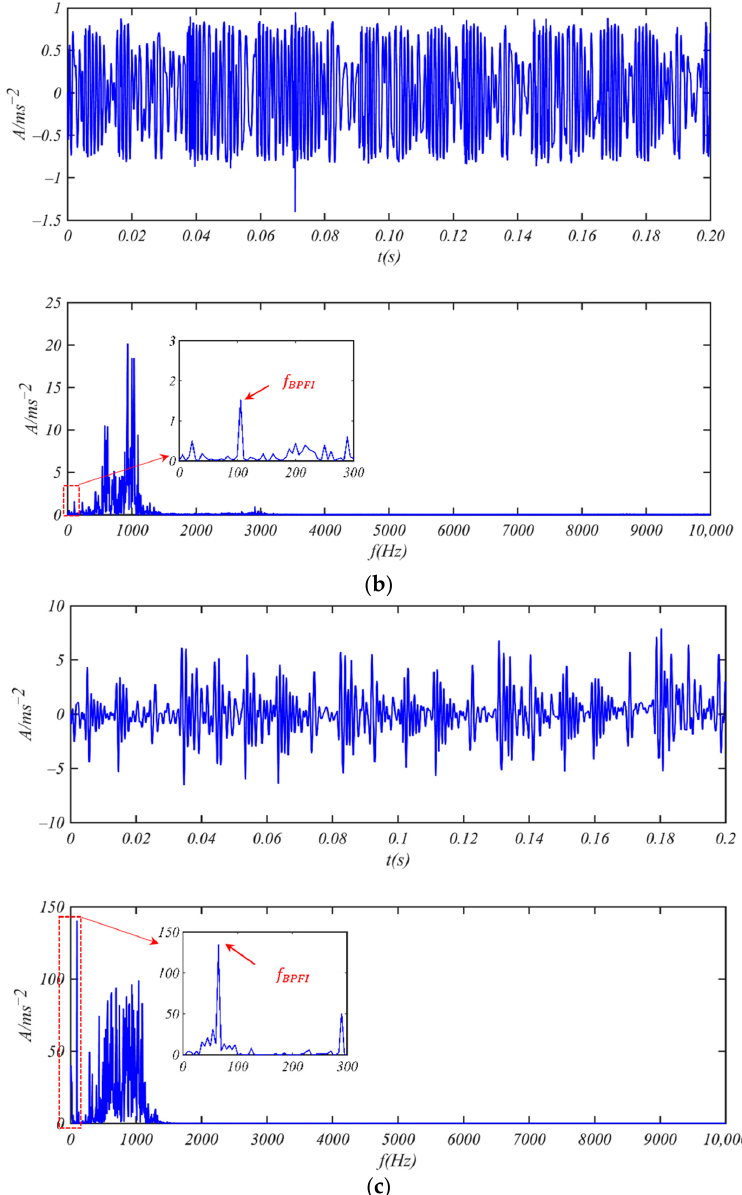
Figure 11. Comparison between different models to process bearing 6200 with inner ring fault: ( a ) origin time-domain waveform and spectrum; ( b ) time-domain waveform and spectrum processed by CBSR model; and ( c ) time-domain waveform and spectrum processed by PNABSR model. (2) 6200-NR NSK Bearing with Weak Outer Ring Fault